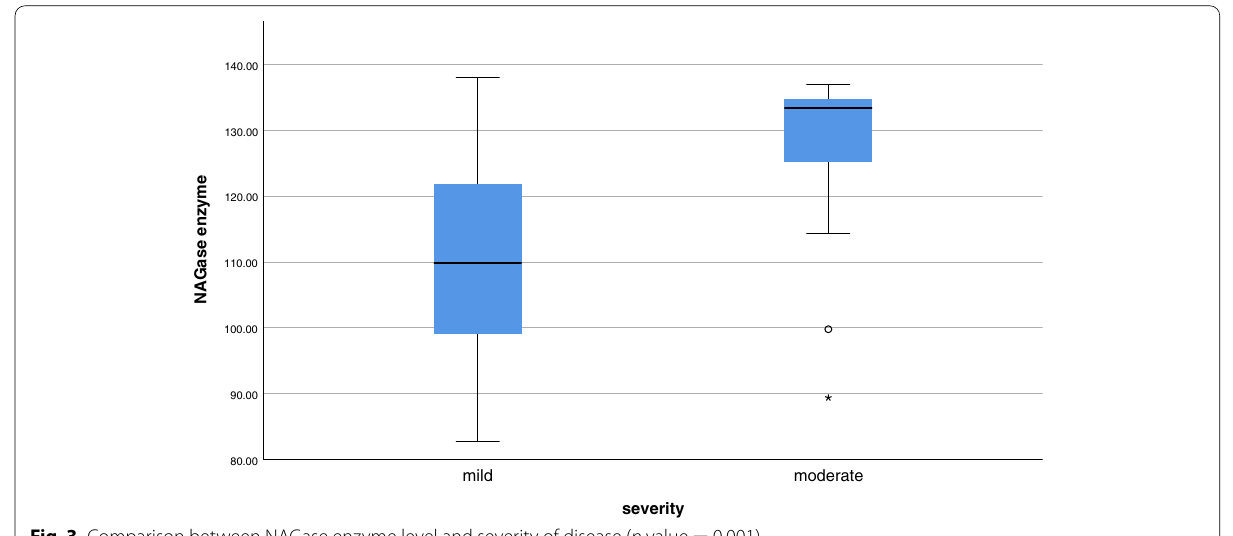
Fig. 3 Comparison between NAGase enzyme level and severity of disease ( p value